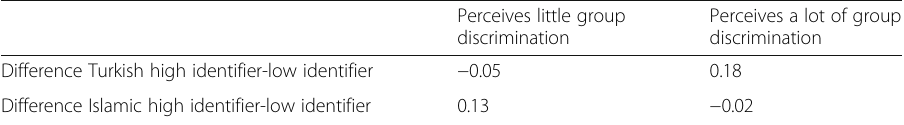
Table 4 Differences in the predicted probabilities between the highest identifiers and lowest identifiers, according to perceived group